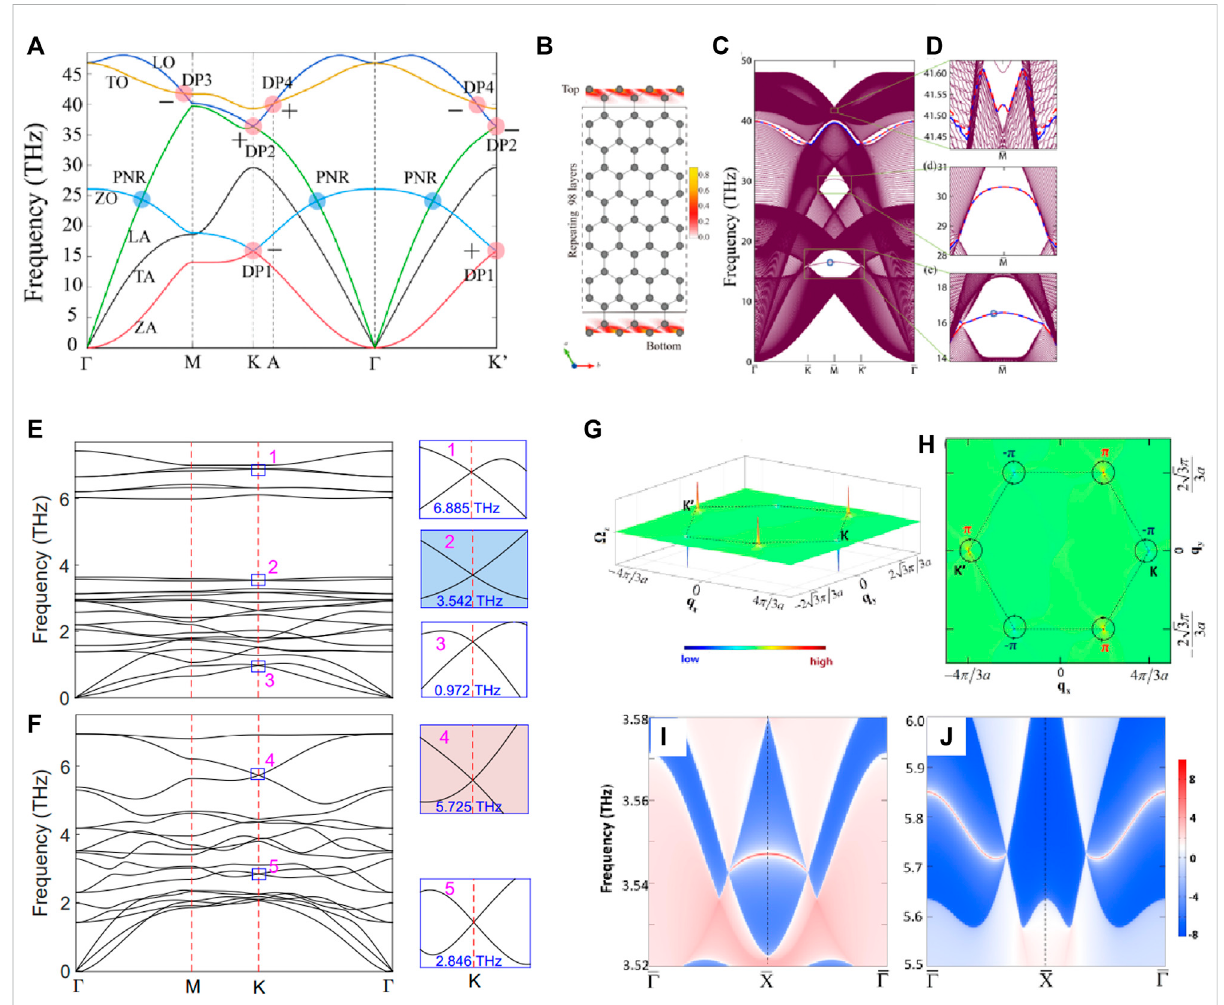
FIGURE 1 (A) phonondispersionforgraphenealong Γ -M-K-A- Γ -K ′ paths.ThepositionsofDP1-DP4andPNRareexhibitedin (A) . (B) Theribbonmodelof graphene with a zigzag-edged boundary. (C) calculated phonon dispersion of the ribbon model and the edge states. (D) (from top to bottom) The enlarged fi gures of the edge states arise from the projections of DP3, PNR, and DP1 phonons, respectively. (E) and (F) the calculated phonon dispersionsfortheCrI 3 monolayerandYGaImonolayer,respectively.BoxesmarkthepositionsoftheDiracpointsattheKhigh-symmetrypoint. Theenlarged fi guresofthephononbandsintheseboxesarealsoexhibitedin (E) and (F) . (G) and (H) differentviewsofBerrycurvaturedistributionsof CrI 3 with the Dirac frequency ω = 3.542 THz. (I) and (J) calculated edge states of semi-in fi nite nanoribbons for CrI 3 and YGaI with a zigzag-edged boundary. Reproduced from Refs. [60, 61] with